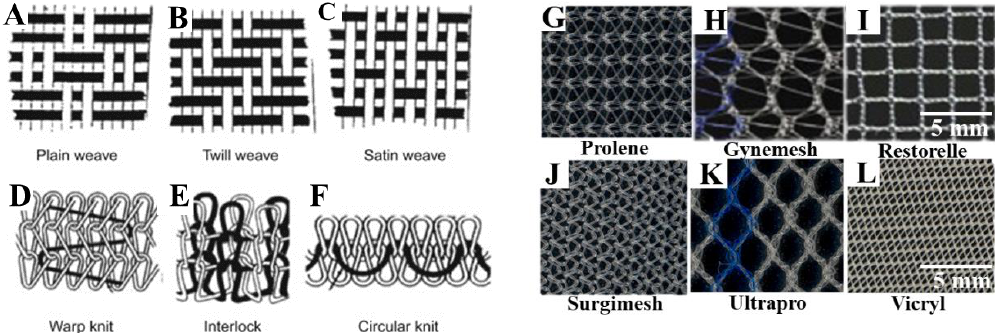
Figure 2. Mesh topography showing fabrication patterns of various types of weaves ( A – C ), types of knits ( D – F ) and commercially available meshes ( G – L ) in POP surgery. Reproduced with permission of [19]. Copyright Elsevier, 2016. Reproduced with permission of [34].